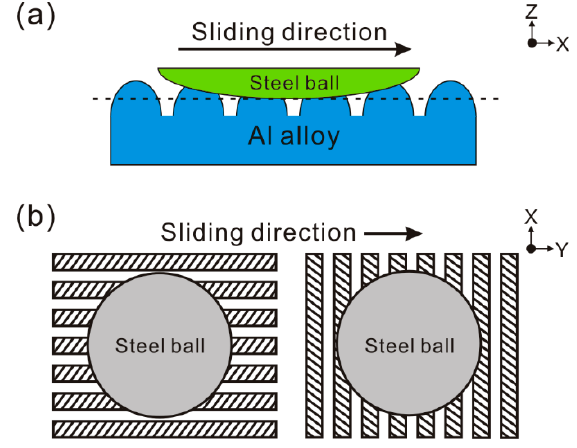
Figure 13. Schematic of the ploughing effect model of micro ‐ scale structure surfaces.